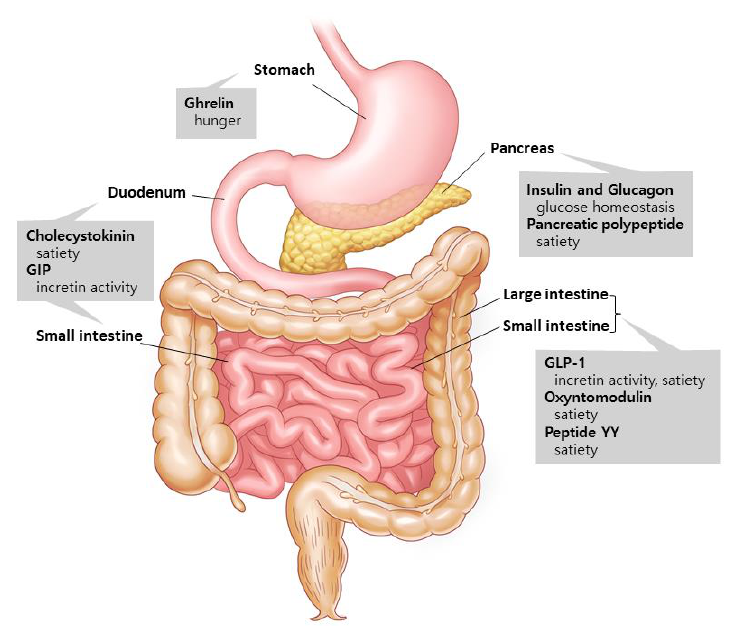
Figure 1. Gut hormones and their supposed actions. Ghrelin is released by the stomach. Insulin, glucagon, and pancreatic polypeptide are excreted from the pancreas. Cholecystokinin and GIP are secreted in the duodenum and small intestines, and GLP-1, oxyntomodulin, and peptide YY are released by the small and large intestines. These hormones from the gastrointestinal tract communi- cate with the peripheral and central nervous systems to control a variety of metabolic activities. Modified from Murphy et al.